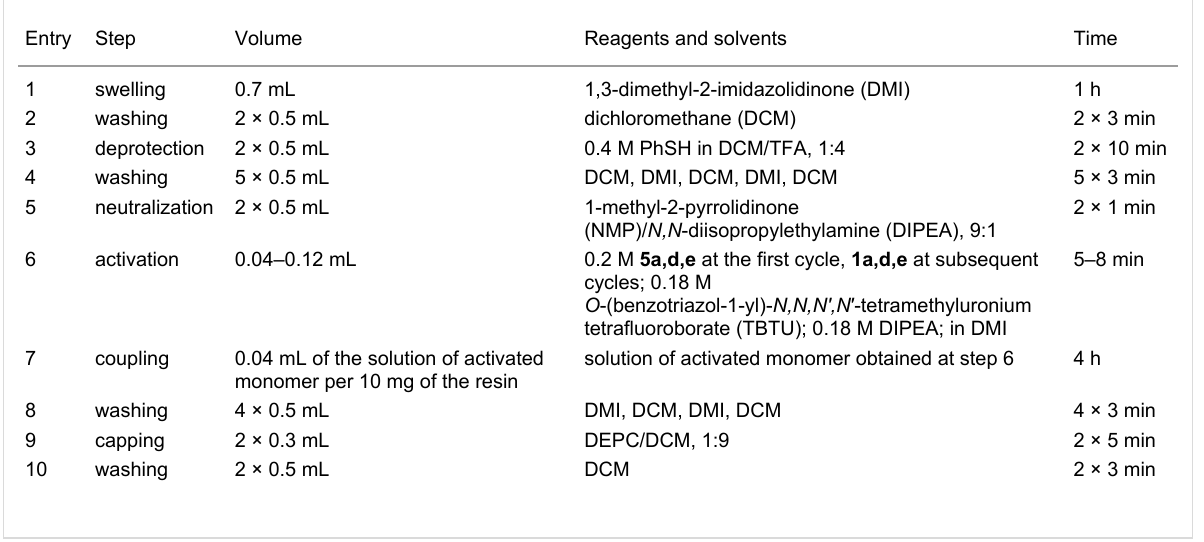
Table 1: SPPS protocol for MorGLy oligomers using Boc-Gly-PAM resin (10–30